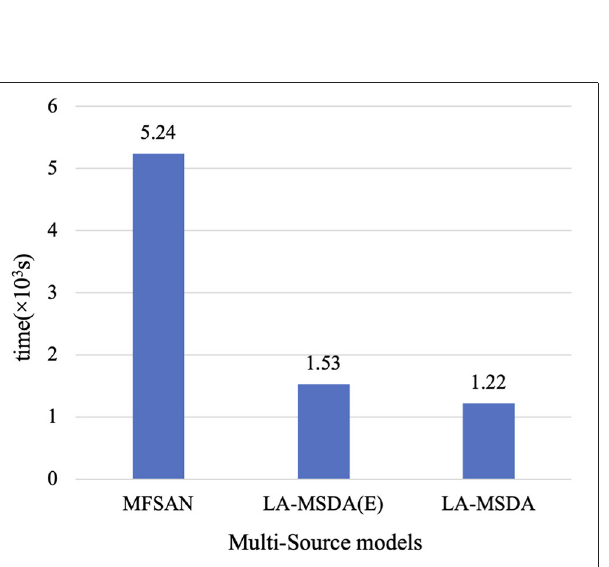
FIGURE 11 | Time of convergence compared with MFSAN, LA-MSDA(E), and LA-MSDA. LA-MSDA(E): only considering stage 1 of LA-MSDA with EEGNet-based